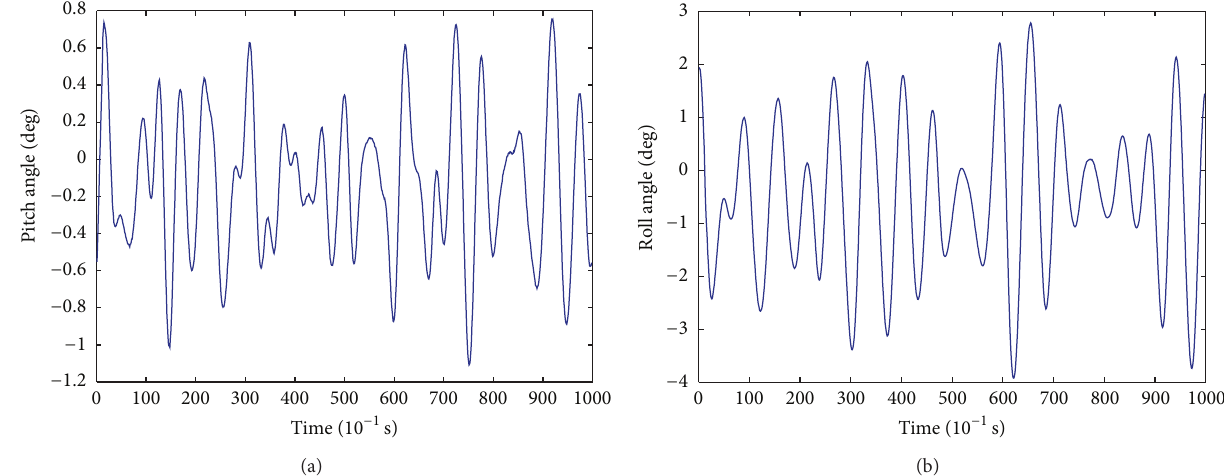
Figure 7: Demonstrating angle variation of (a) pitch and (b) roll signals measured by gyroscope.